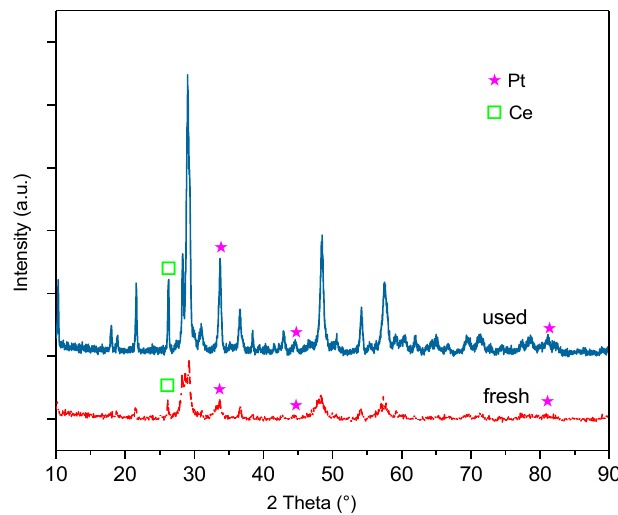
Figure 10. XRD patterns of Pt / Rh TWC catalysts for 2 θ between 10 ◦ and 90 ◦ in the fresh state and after